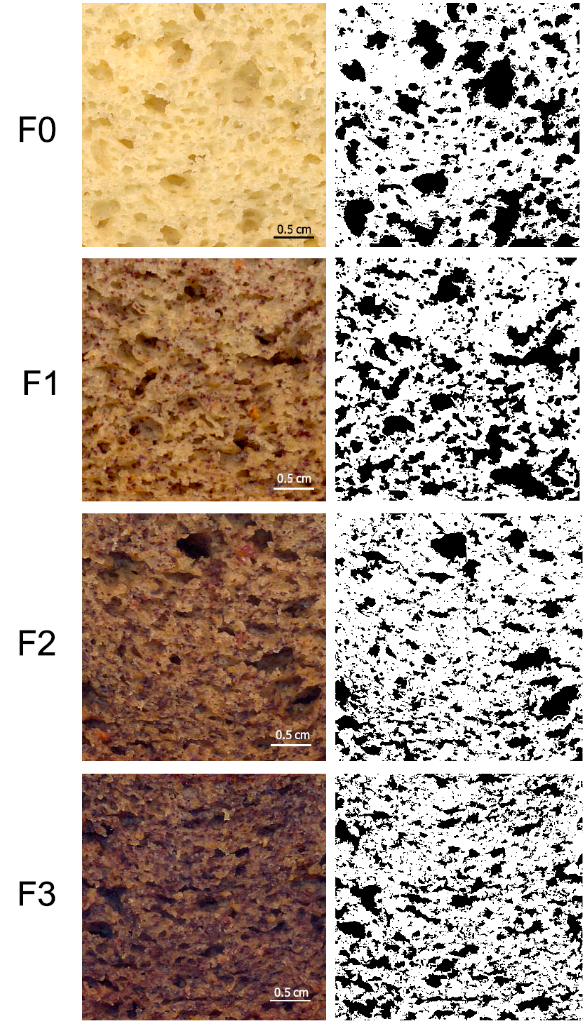
Figure 1. Scanned crumbs (left) and binarized images of scanned crumbs (right) of the muffins. F0: muffins without persimmon flour (control sample). F1: 10% replacement of corn flour with persimmon flour. F2: 20% replacement of corn flour with persimmon flour. F3: 30% replacement of corn flour with persimmon flour. Table 3. Muffin height and crumb structure